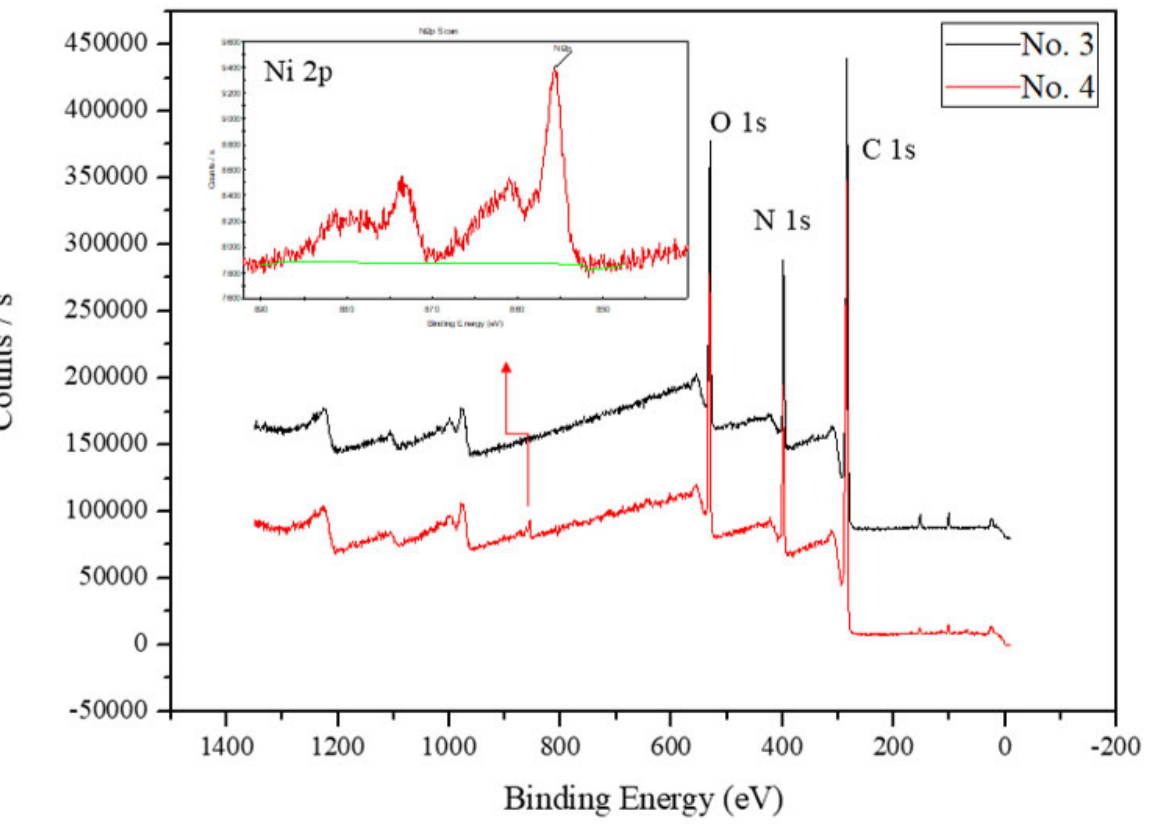
Figure 5. XPS survey scan spectra of the prepared catalytic electrode surface by plasma deposition (see Table